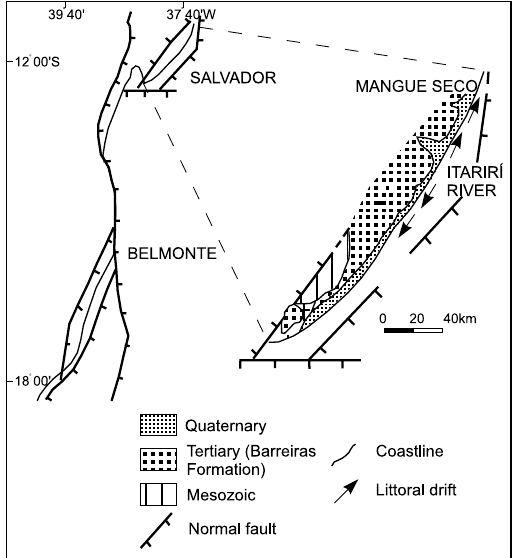
Fig. 7 - Simplified tectonic framework of the marginal basins of the State of Bahia (modified from Campos et al. 1974). The figure also shows a map based upon Campos et al. (1974), and Martin et al.